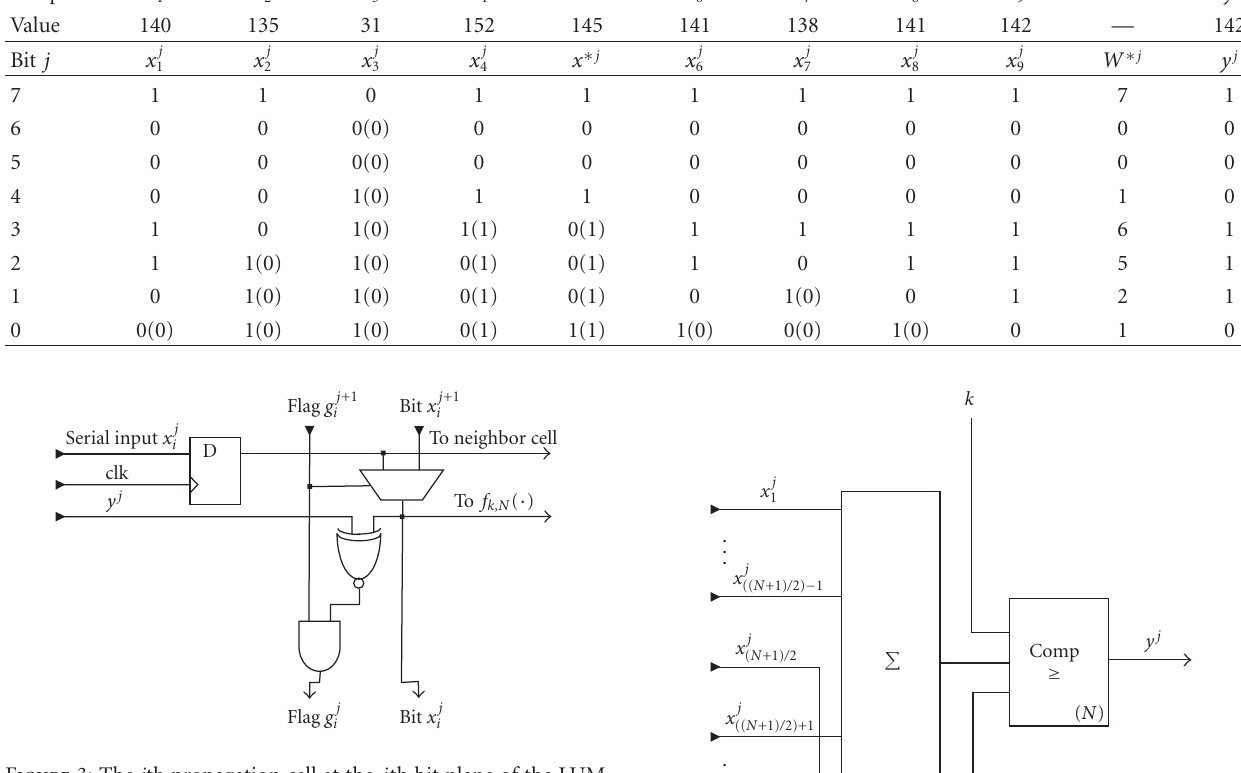
Figure 3: The i th propagation cell at the j th bit plane of the LUM smoother.